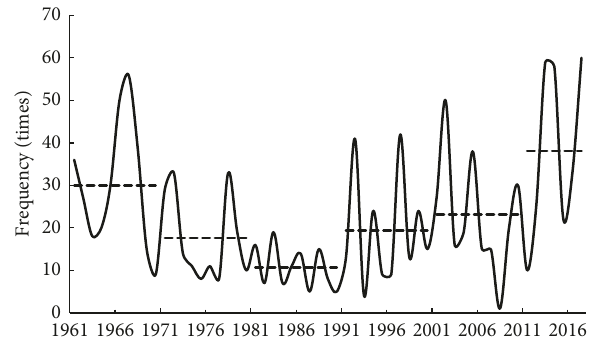
Figure 2: Frequency of heatwave events on the North China Plain.